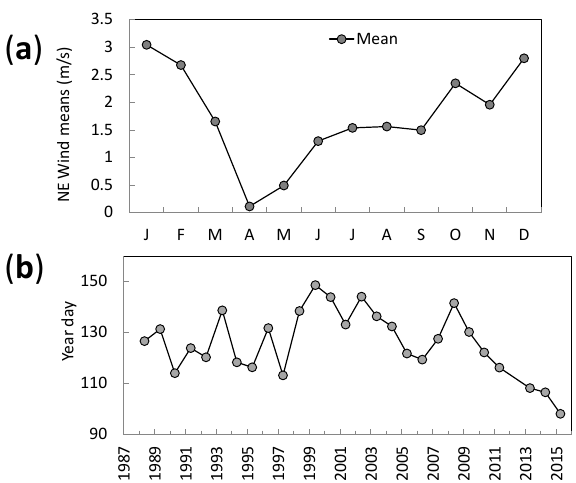
Figure 6. (a) Annual cycle in the mean monthly wind speed in the NE direction in the Baltic Sea (area indicated in Fig. 1a). (b) Day of the year when the 5-day mean wind in the NE direction exceeds 2ms − 1 for the first time after the April